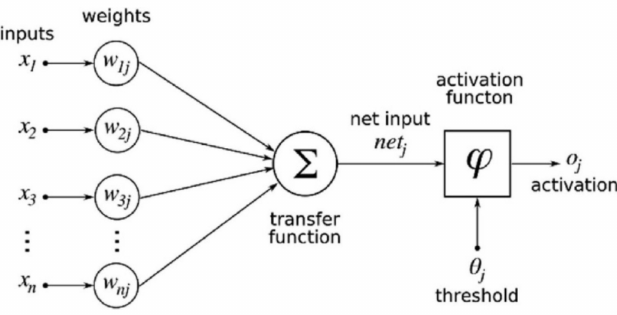
Figure A1. Single artificial neuron schema